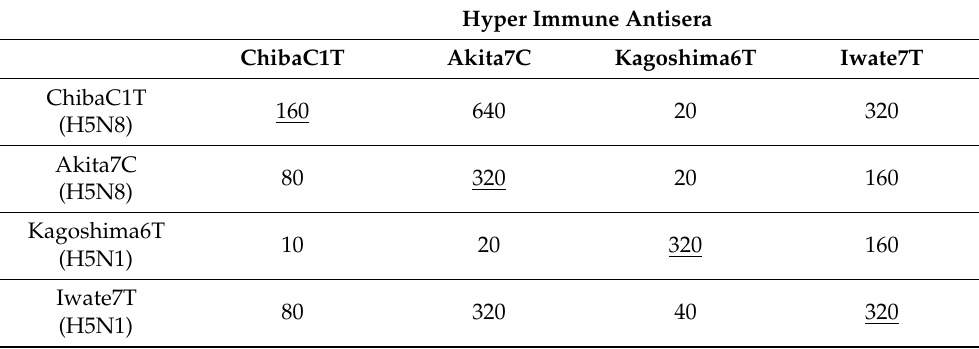
Table 3. Serological cross-reactivity among H5 viruses by hemagglutination inhibition assay. Hyper Immune